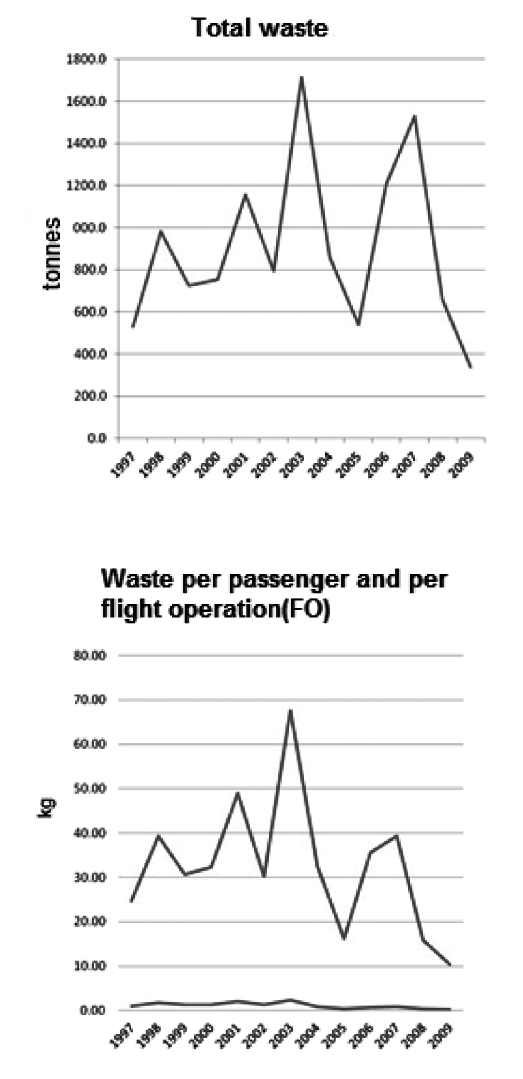
Fig. 8. Waste bin in Tallinn Airport passenger terminal (Keskküla 2012a)